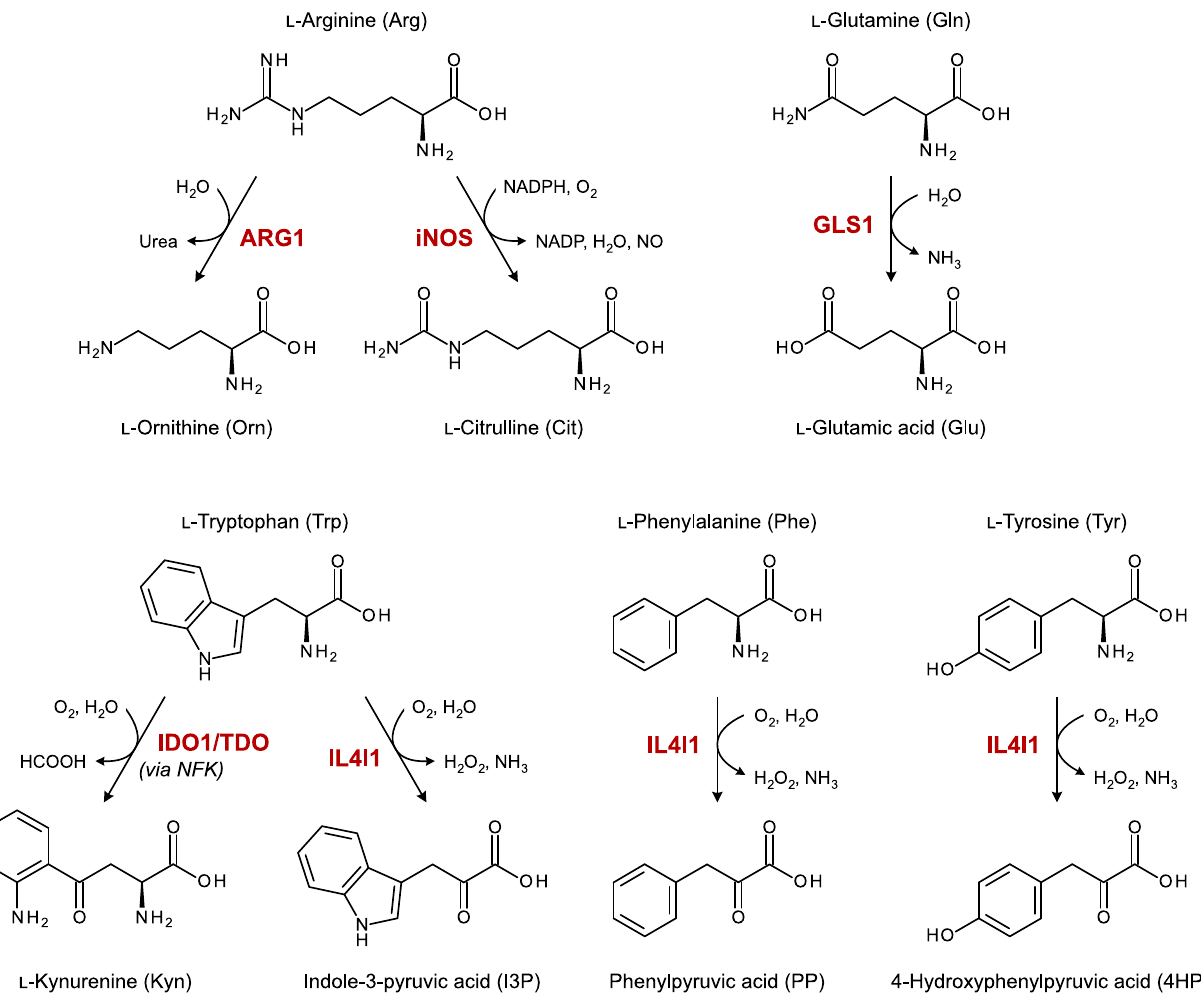
Figure 1. Overview of enzymatic reactions catalyzed by amino-acid metabolizing enzymes with known immunosuppressive properties in cancer. ARG1: arginase 1; GLS1: glutaminase 1; IDO1: indoleamine 2,3-dioxygenase 1; IL4I1: interleukin 4 induced 1; iNOS: inducible nitric oxide